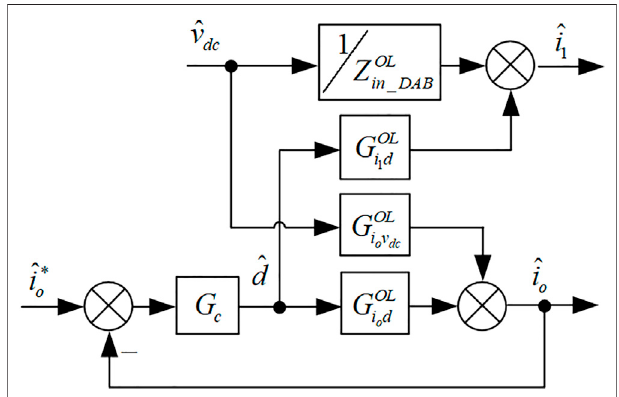
FIGURE 4 | Control block diagram of DAB converters.